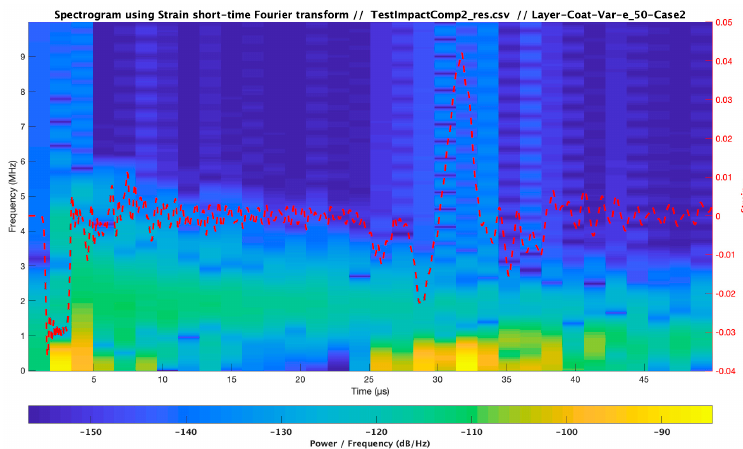
Figure 26. Spectrogram for strain evolution at the middle coating layer, 50% thickness, considering substrate-filler as semi-infinite with increased thickness (shells, tapes). Case 2.